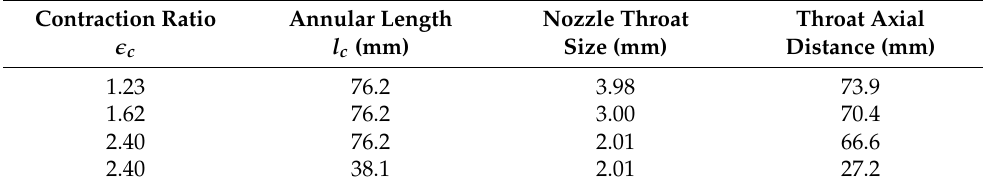
Figure 2. Various RDRE nozzle geometries including the ( a ) conceptual view of the modular configu- ration, along with the ( b ) tested center bodies for both the l c = 76.2 mm and 38.1 mm designs. Table 1. Relevant dimensions for the investigated convergent